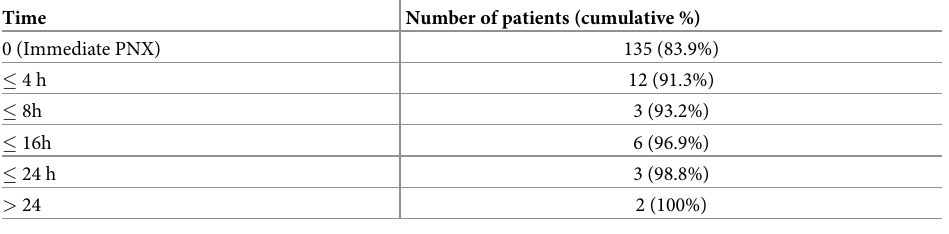
Table 2. The cumulative incidence of pneumothorax (PNX) according to the time of detection (n = 161).